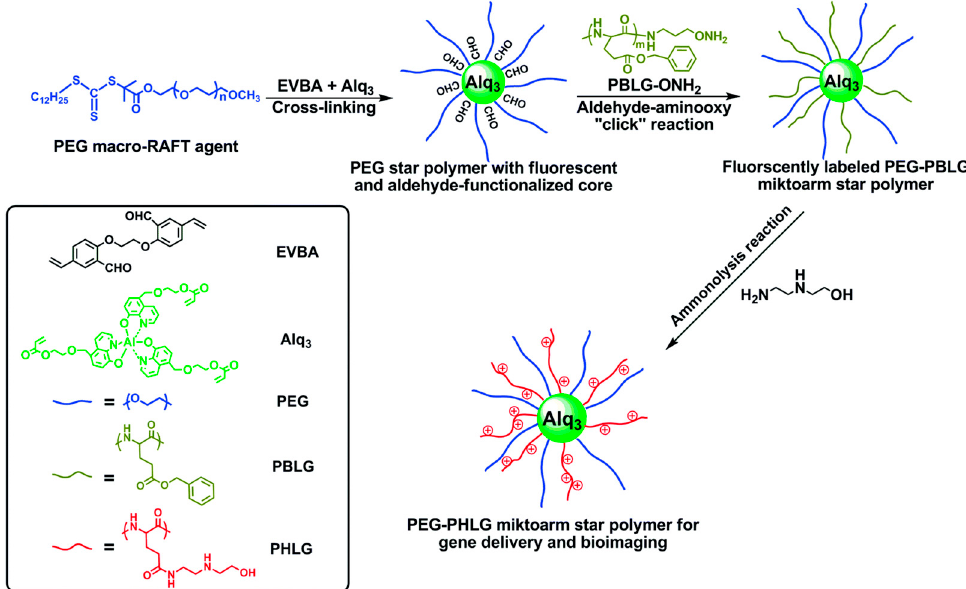
Figure 3. Schematic representation of PEG-PHLG CCS polymer synthesis using an in-out methodology. Reprinted with permission from reference [61]. Copyright 2016 Royal Society of Chemistry.